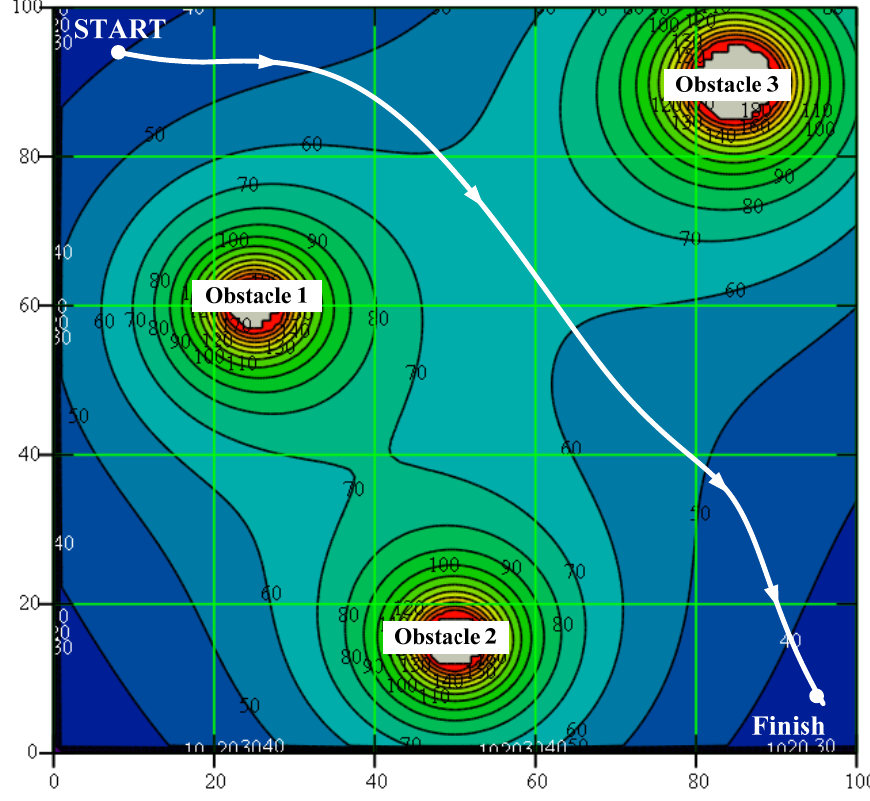
Figure 7. Graphical representation of a potential field.